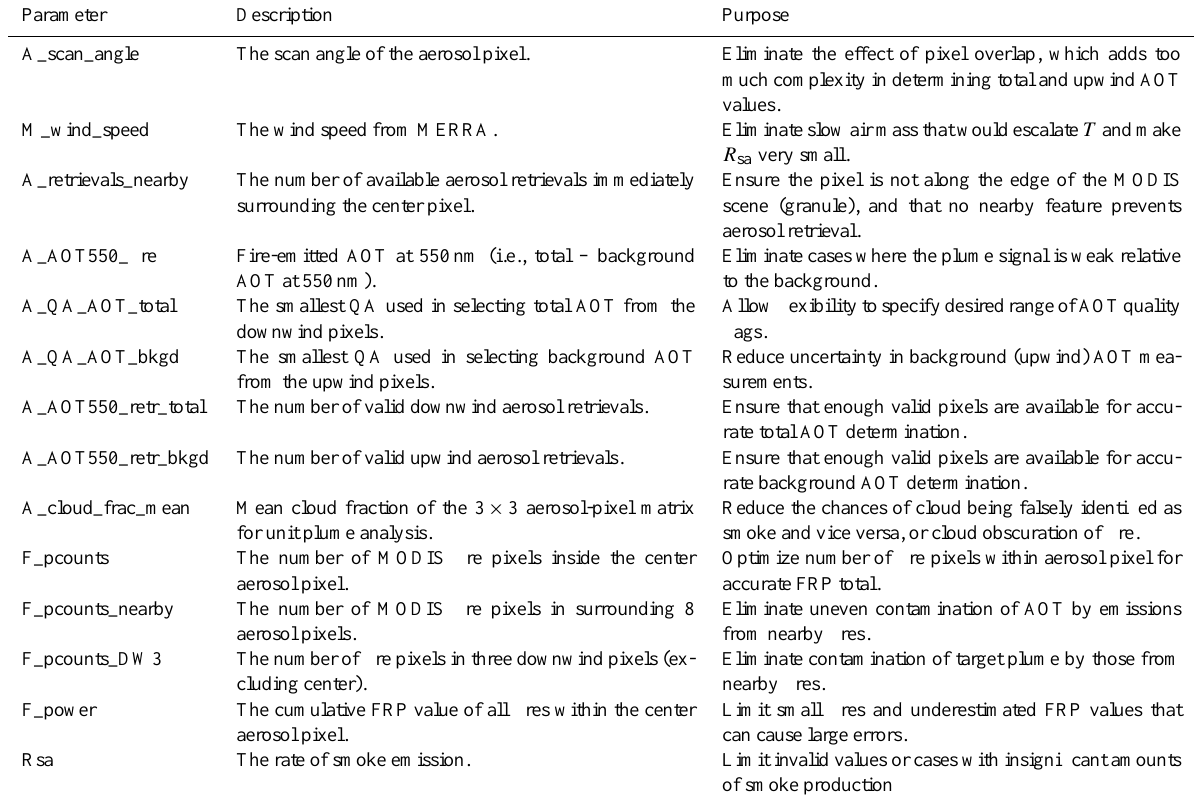
Table 1. List of parameters that are used for data filtering in the gridded product development step described in Sect. 4.3 (parameter-name prefixes “A”, “F” and “M” indicate whether a parameter belongs to the MODIS Aerosol, MODIS Fire, or MERRA Meteorological data sets,